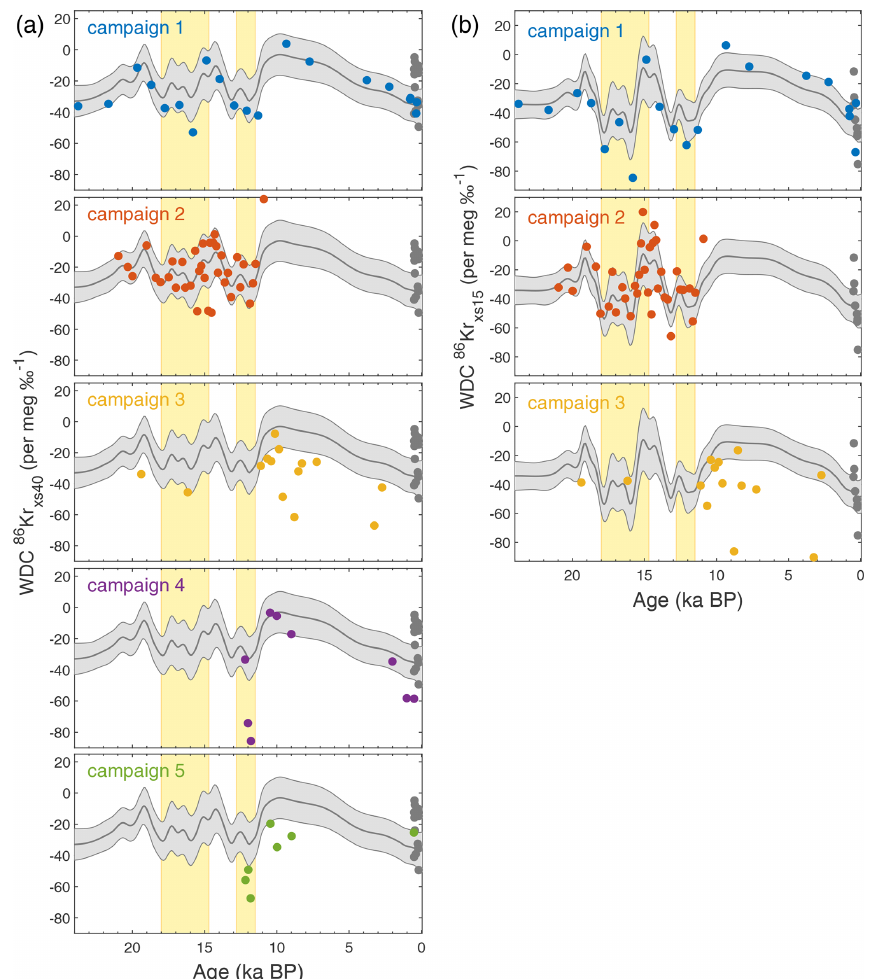
Figure 6. WAIS Divide Kr-86 excess records through the last deglaciation. (a) WDC 86 Kr xs40 data from the five measurement campaigns. The gray curve shows a Gaussian smoothing curve to the combined data from the first two campaigns; the light gray shaded area shows the ± 1 σ uncertainty envelope based on a 10000-iteration Monte Carlo sampling of the errors and uncertainties. The WDC calibration data are shown as gray circles for comparison. (b) As in panel (a) , but for 86 Kr xs15 . For campaigns 4 and 5 the sample was not split, and no δ 15 N data are available. The Heinrich Stadial 1 and Younger Dryas North Atlantic cold periods are marked in yellow. Thermal corrections in the WDC 86 Kr xs records are based on firn model simulations; gas loss correction is based on a third-order polynomial fit to the WDC gravity-corrected δ O 2 / N 2 −− δ Ar / N 2 (Fig.